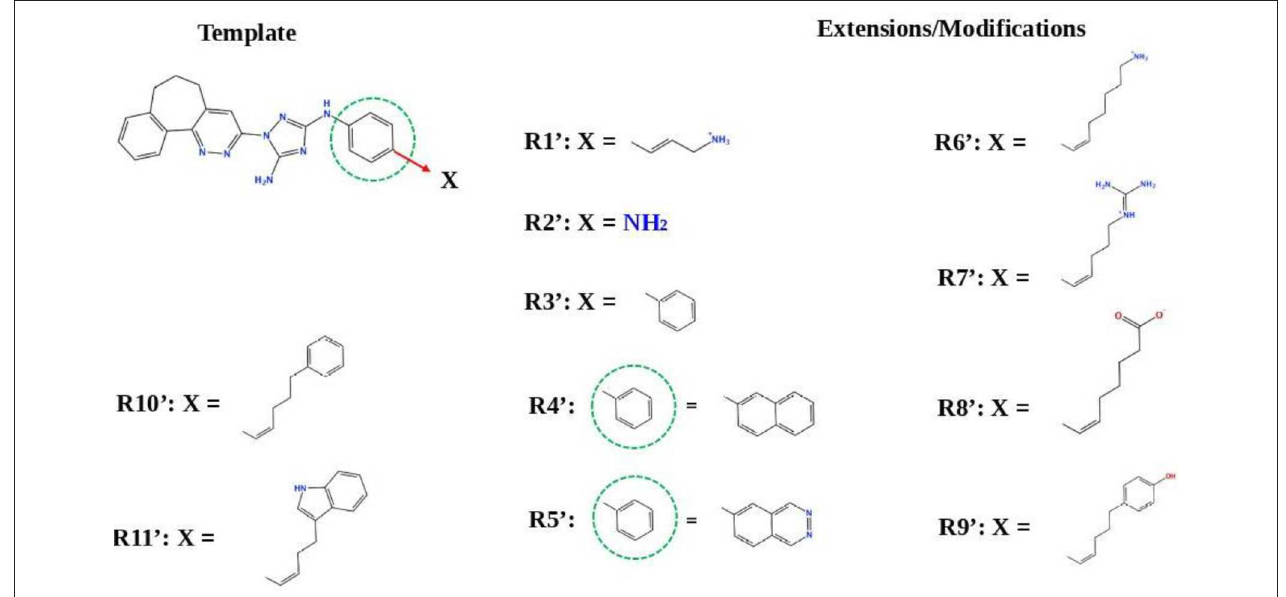
FIGURE 6 | The strategy of the design of the new compounds based on the R428_2, R428_3, and R428_4 template extension. The upper-left part is a template. The upper- and lower-right parts are extensions/modifications of the template.